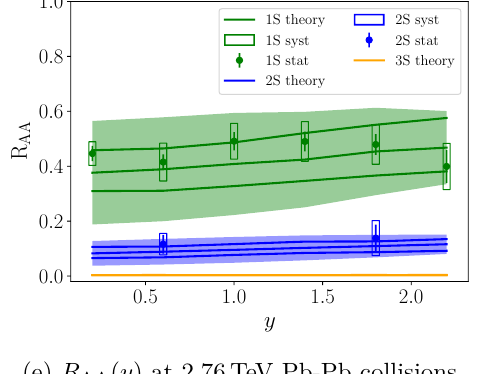
Figure 5. Bottomonia R AA as functions of centrality, transverse momentum and rapidity at 2 . 76 TeV Pb-Pb and 200 GeV Au-Au collisions. The upper and lower curves correspond to calcu- lations with parameters that differ by ± 10% respectively from the parameters used in the middle curve. The band indicates the nPDF uncertainty that is centered at the middle curve. Data of the CMS and STAR measurements are taken from refs. [87] and [81] respectively. The p T dependence of R AA for the 200 GeV Au-Au collisions is calculated and compared for the centrality range 0 − 60%